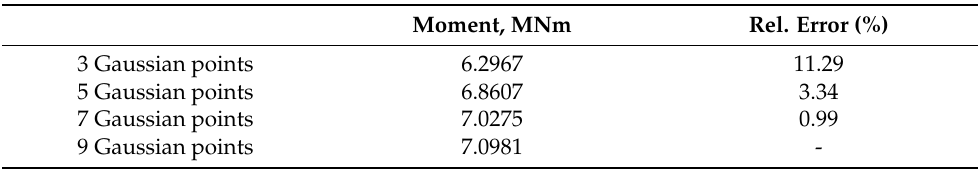
Table 3. Comparison of results for four elements under bending.